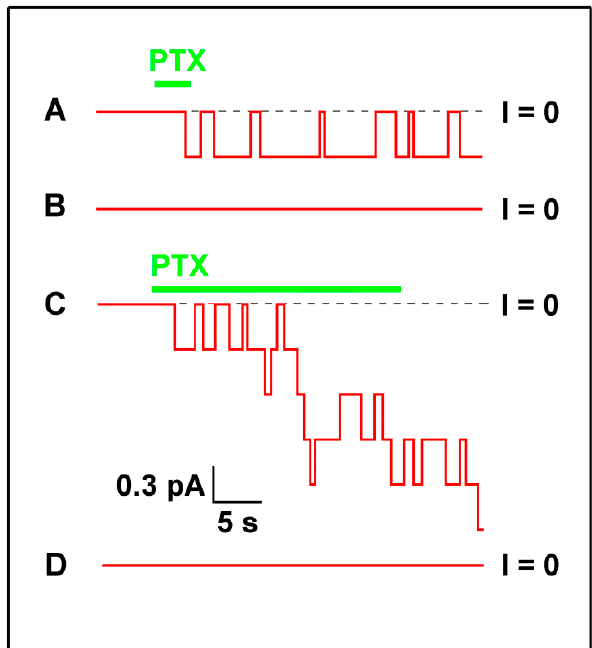
Figure 8. Schematically represented palytoxin (PTX) induced ion- channel behaviour of the Na,K-ATPase. A. In the presence of Na + and Mg·ATP and 25 pM PTX for a few seconds typical opening and closing of a single cation-selective channel were observed. B. After washout of PTX no longer channel events could be recorded and ion-pump activity was restored. C. Upon prolonged exposure to 25 pM PTX more and more Na,K-ATPase molecules were transformed into ion channels. D. In the presence of high concentrations of oua- bain channel activity was completely suppressed. Figure adapted from Artigas & Gadsby 209